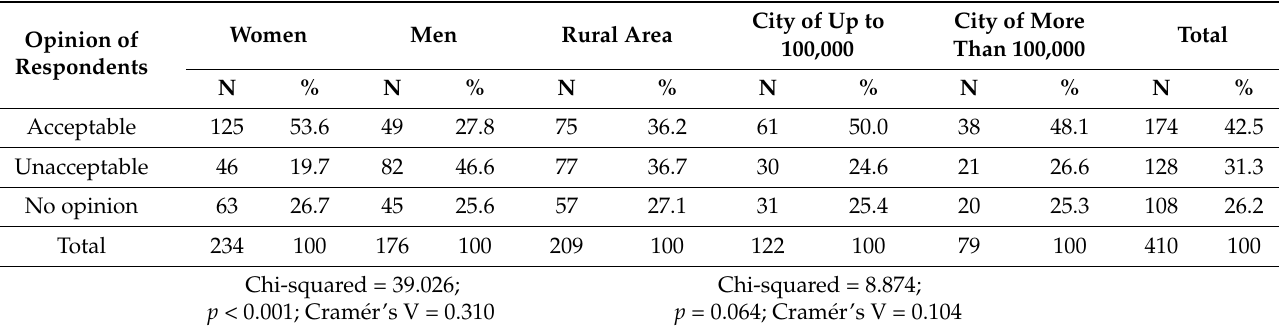
Table 7. Acceptance of homosexual